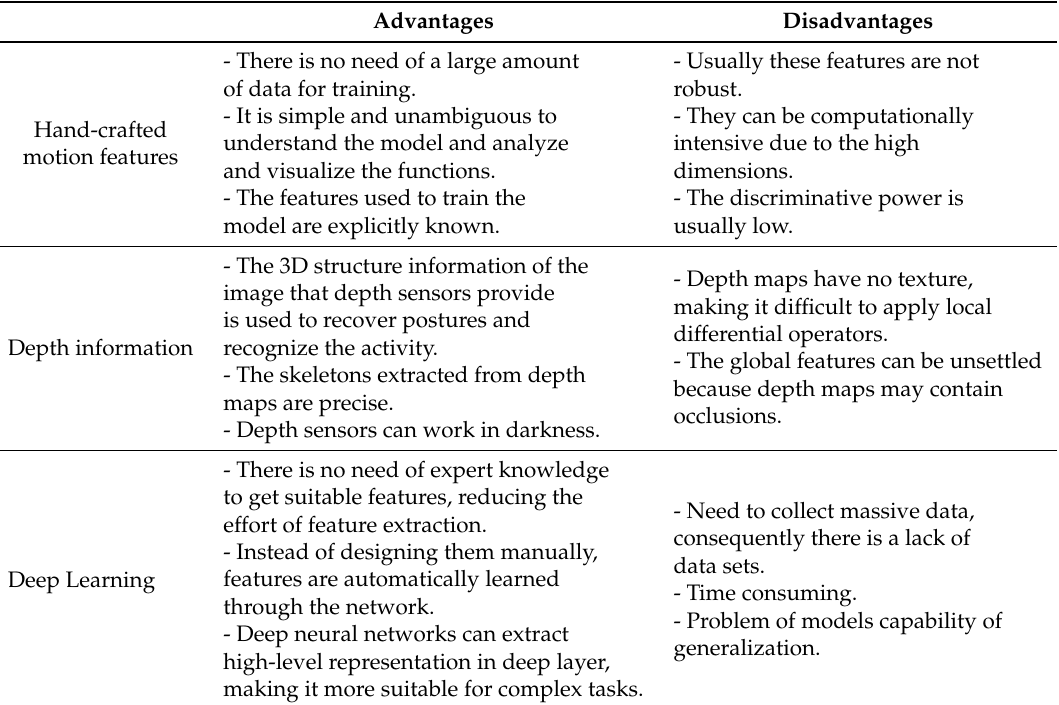
Table 4. Advantages and disadvantages of presented